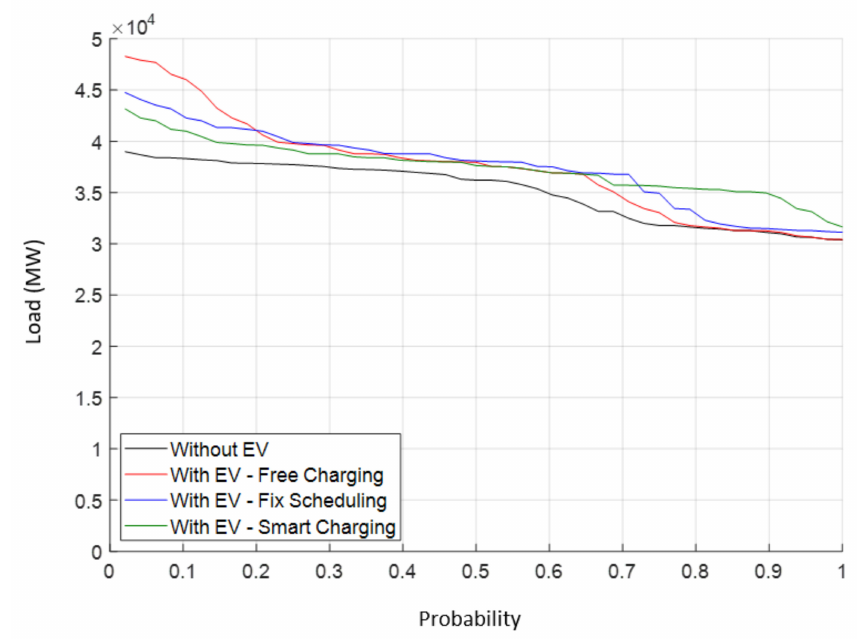
Figure 7. Java-Bali daily load duration probability curve.